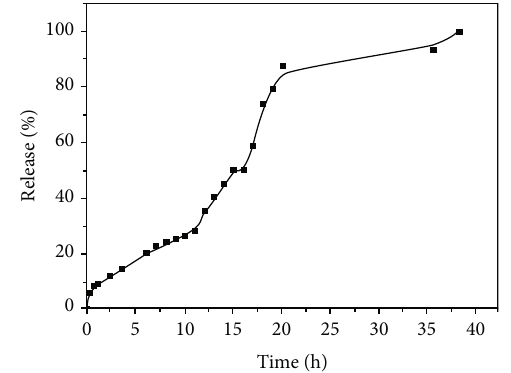
Figure 38: Plot of release of encapsulated Congo Red from PMMA microcapsules